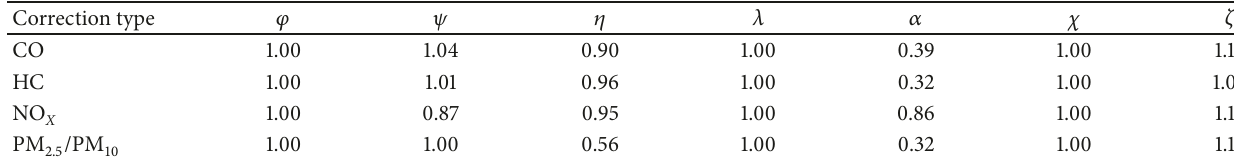
Table 10: Regional emission correction factor of Zibo City.